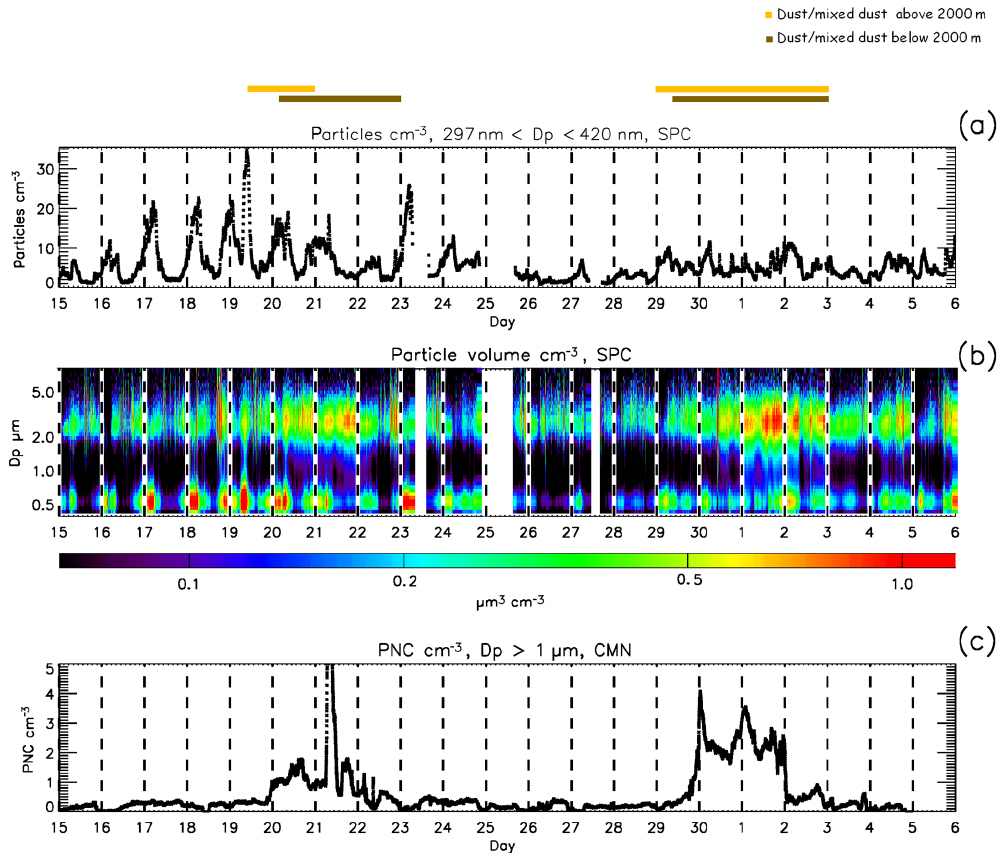
Figure 4. (a) APSS particle counts at 297–420nm of diameter. (b) Time series of the volume size distribution of aerosol particles as observed by the APSS. The y axis indicates the volume-equivalent particle diameters in micrometres while colours report the corresponding volume concentration. (c) Time series of coarse ( D p > 1µm) particle number concentration observed at CMN. Dust/mixed dust presence, as seen by lidar, is indicated as in Fig.